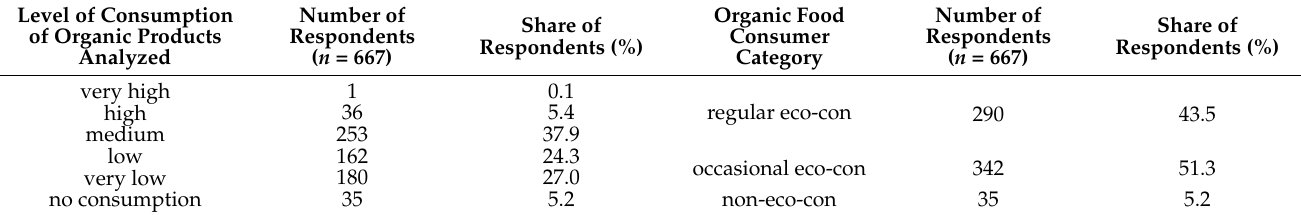
Table 5. Level of organic food consumption in the surveyed group of respondents ( n =